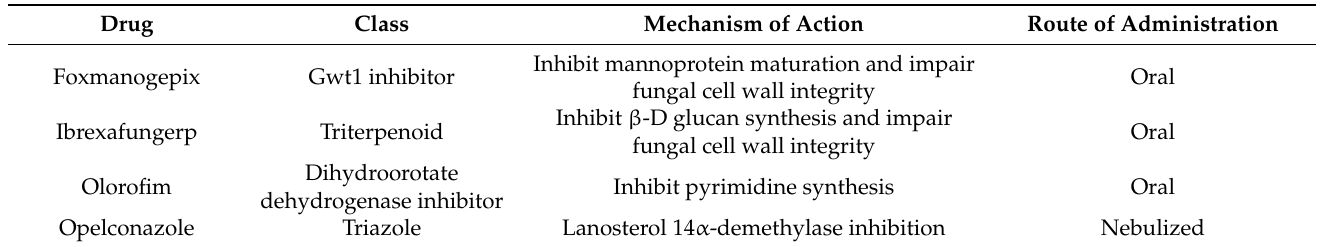
Table 2. Novel antifungal therapies for invasive pulmonary